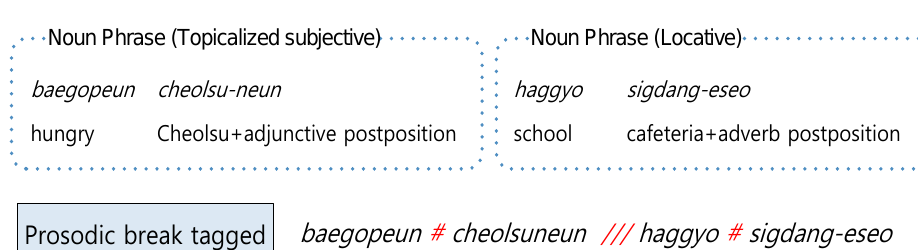
Figure 2. Prosodic break realization in boundaries of syntactic phrases.